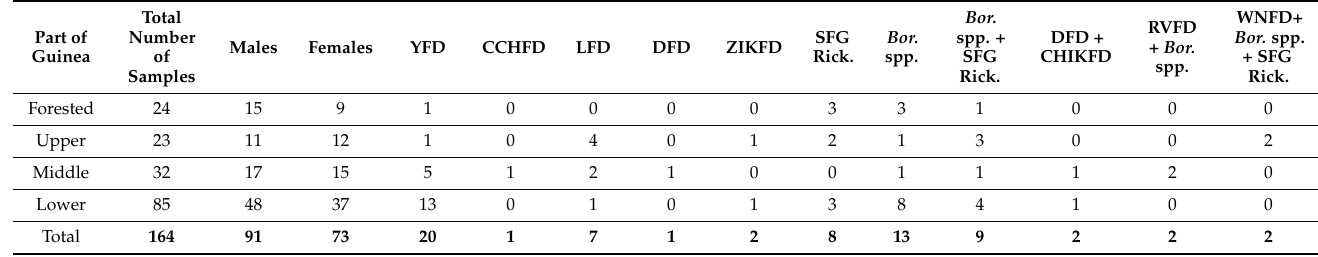
Table 4. Analysis results from acute febrile illness patient